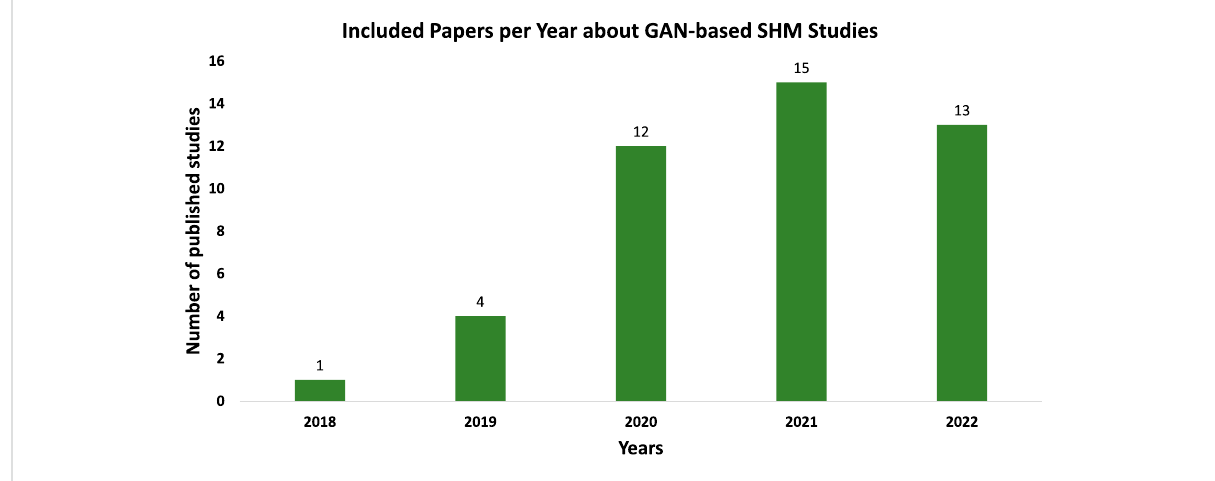
FIGURE 5 The number of papers included in this study published on GAN-based SHM after the PRISMA fl ow diagram presented in Figure